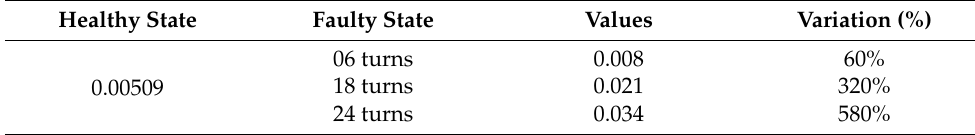
Figure 16. ZVF response for three different ITSCF severities. Table 4. ZVF values for different ITSC fault severities.